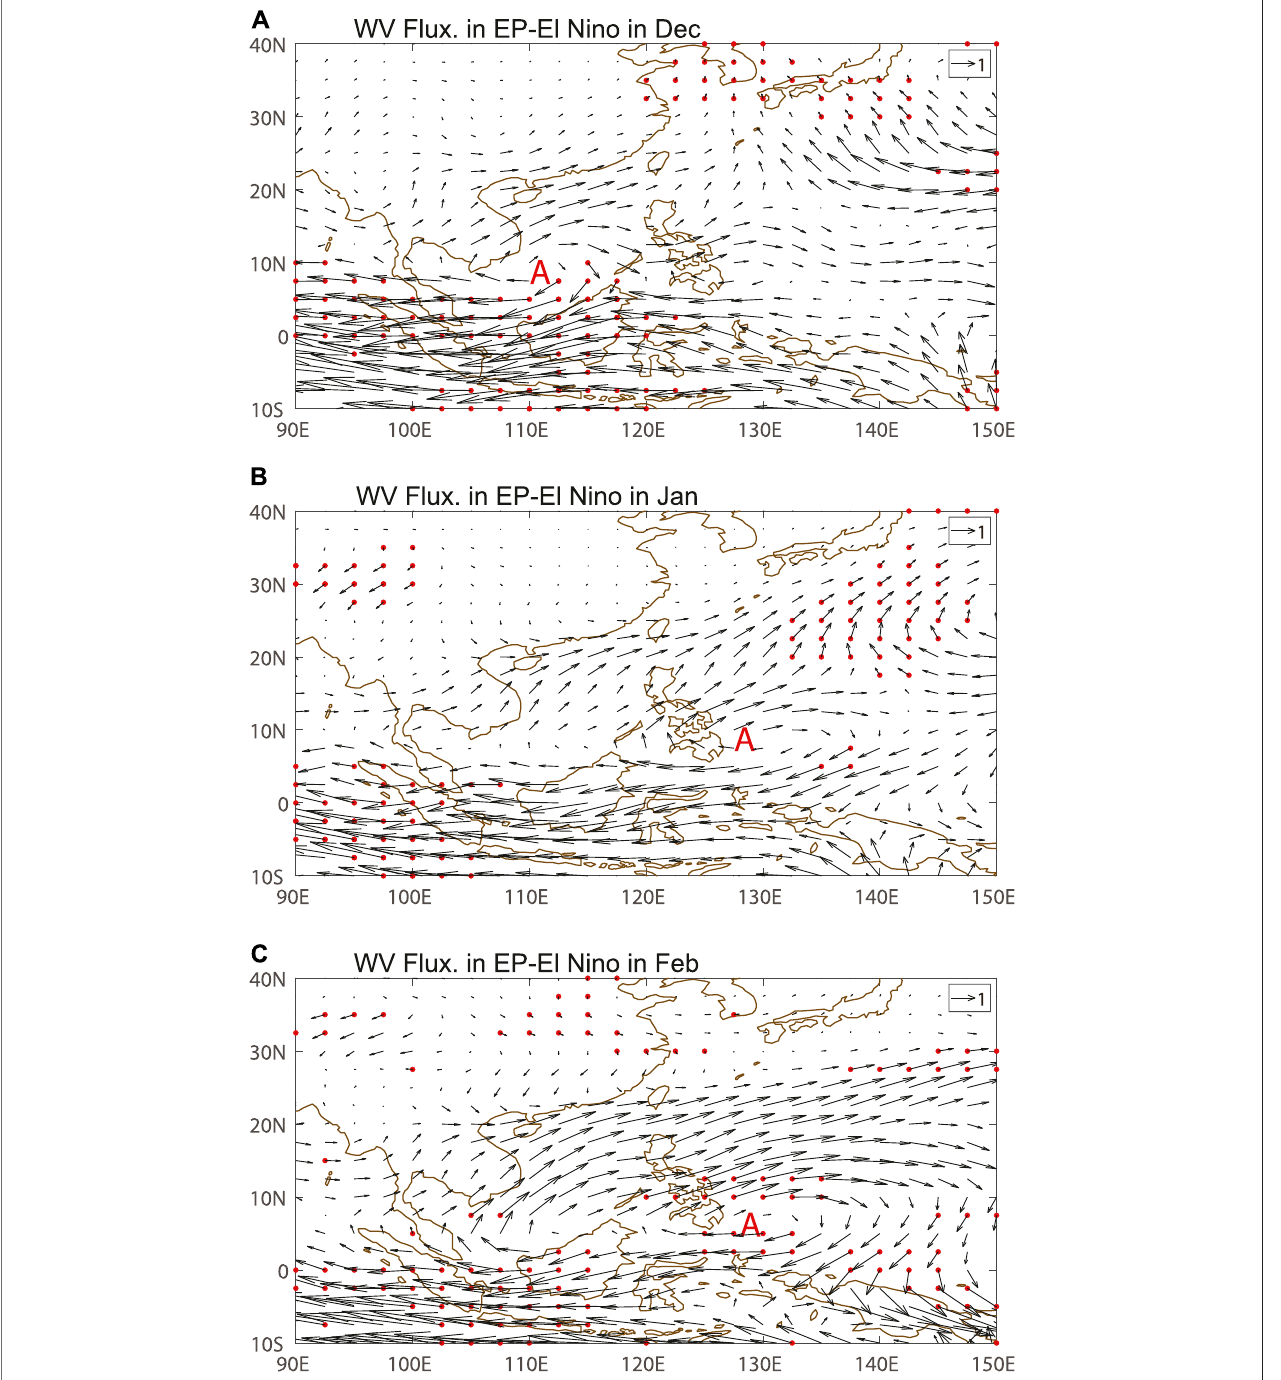
FIGURE 8 | Water vapor transport anomalies (units: kg m − 1 s − 1 ) during El Niño mature phases in (A) December, (B) January, and (C) February. Dotted areas indicate the 0.05 signi fi cance level. “ A ” indicates the center of an anticyclone.